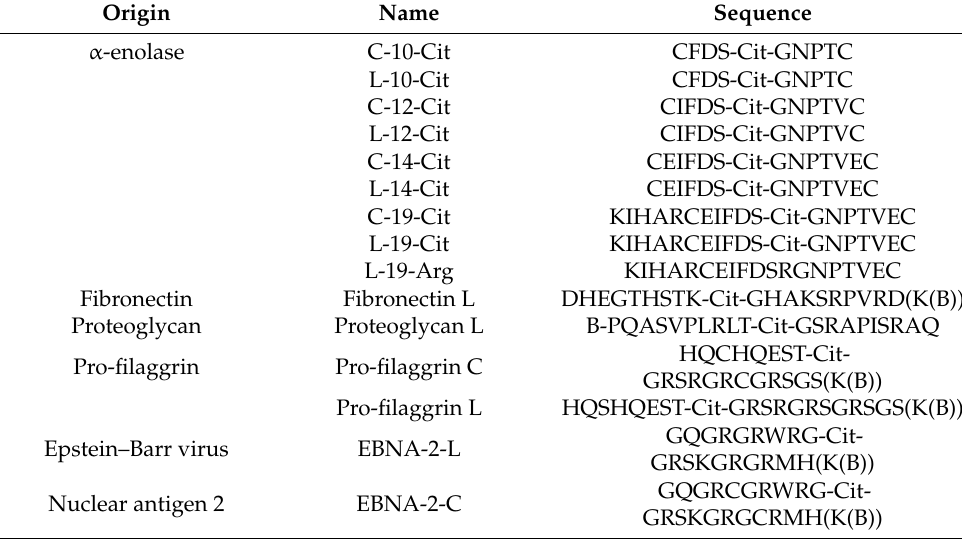
Table 1. Synthetic peptides tested for antibody reactivity. “B” represents